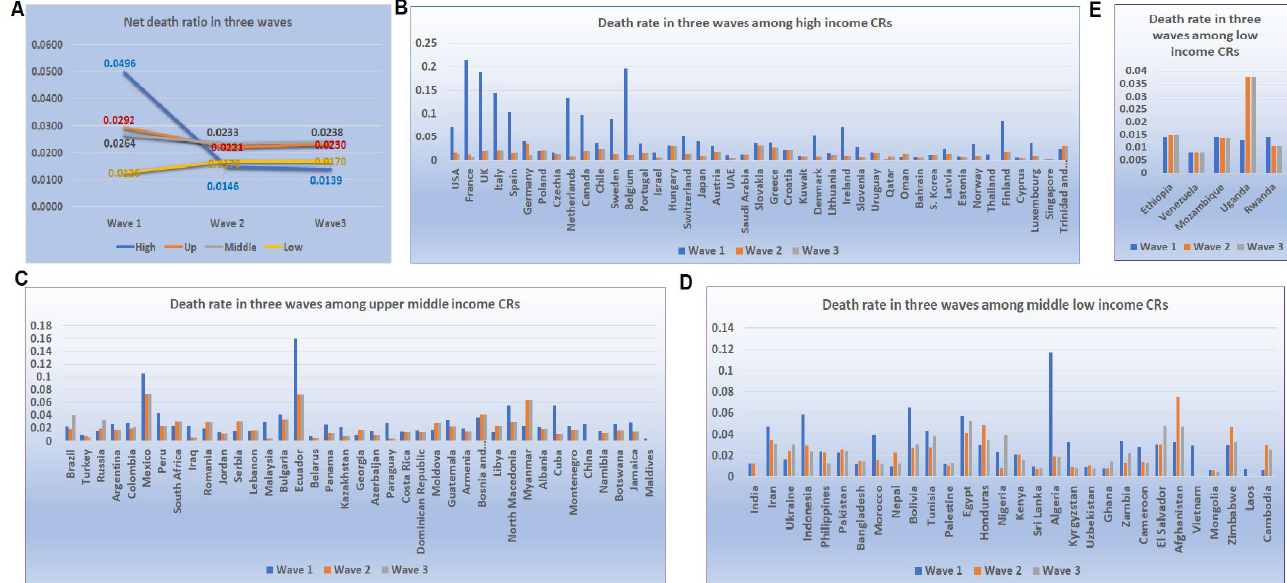
Figure 3. Turning point mortalities during the first three waves of COVID-19 disease in countries according to income levels. ( A ) The average mortalities for waves 1, 2, and 3 in countries of high-, upper-middle-, and lower-middle-incomes, respectively. ( B ) The mortality in three waves in CRs of high-income levels. ( C ) The mortality in three waves in CRs of upper-middle-income levels. ( D ) The mortality in three waves in CRs of lower-middle-income levels. ( E ) The mortality in three waves in CRs of low-income levels.